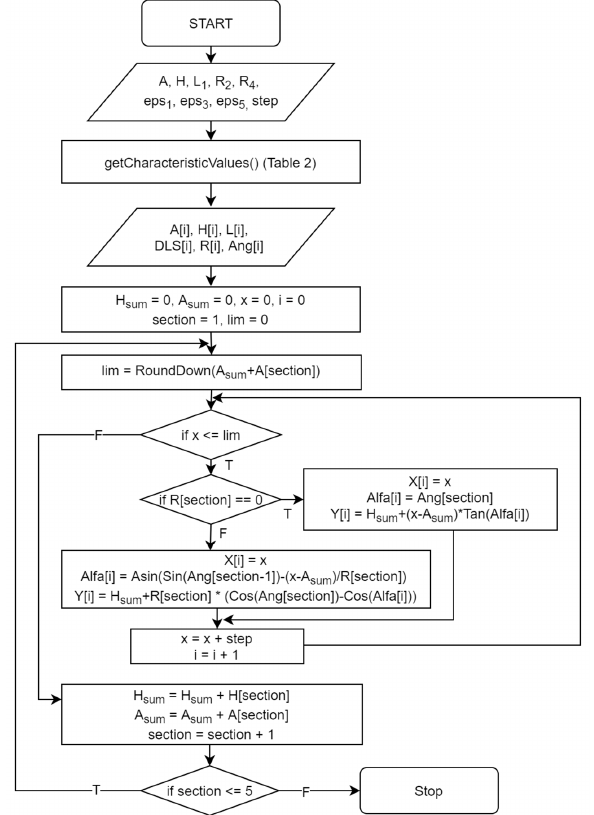
Figure 4. Simplified algorithm for determining the spatial coordinates of trajectories being a Figure4. Simplifiedalgorithmfordeterminingthespatialcoordinatesoftrajectoriesbeingacombination combination of straight and curvilinear sections. of straight and curvilinear